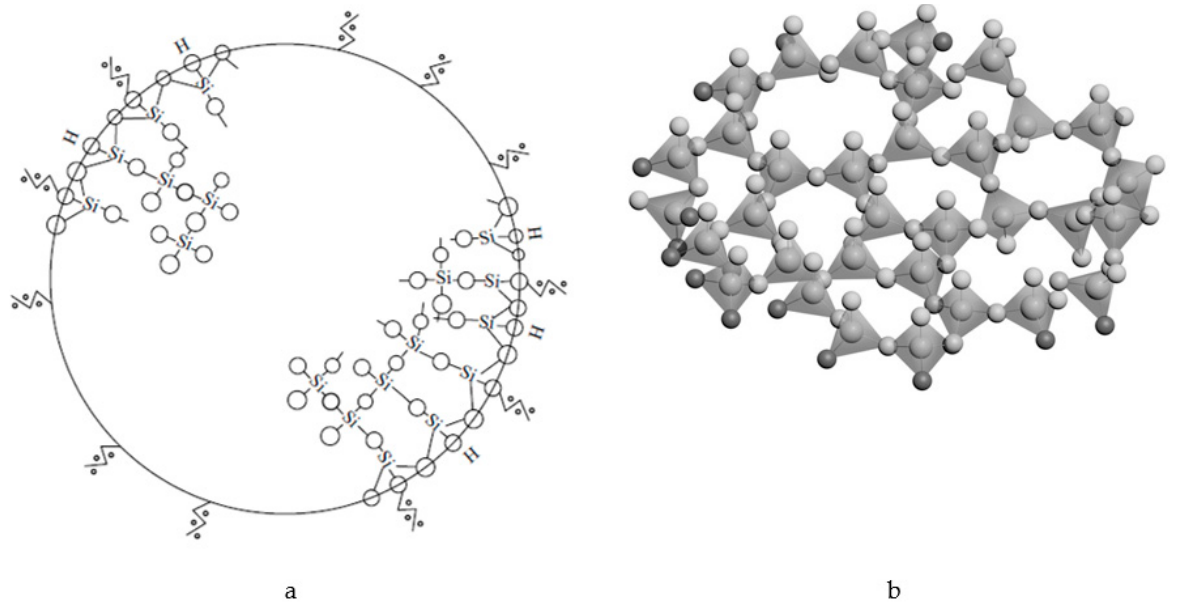
Figure 5. A schematic representation of the primary sol particle ( a ), united polymorphoids ( b ).